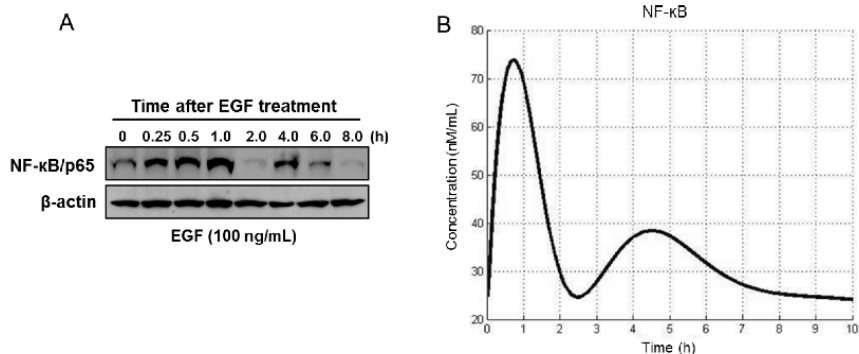
Figure 3. Simulation of constitutive activation of NF- κ B response after EGF treatment. ( A ) RWPE1 cells were stimulated with EGF (100 ng/mL) for periods of 0.25 to 8 h and subjected to Western blotting for estimation of NF- κ B/p65. ( B ) Computation of the time course of NF- κ B activation. Details are provided in the Materials and Methods section.